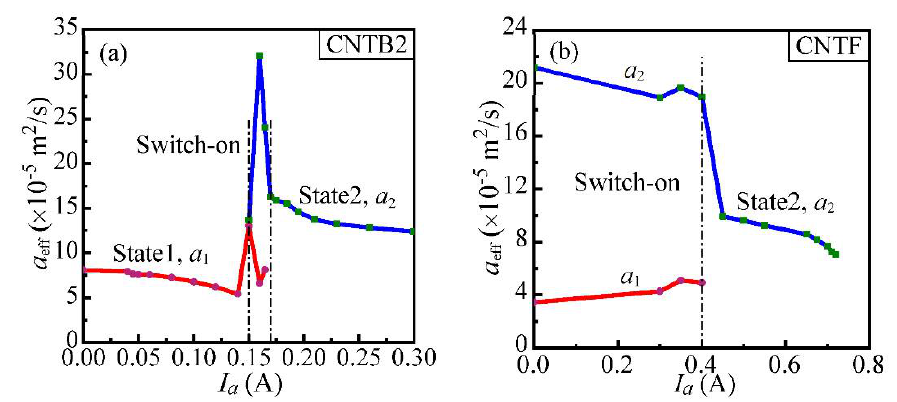
): ( a ) CNTB2; ( b ) CNTF. a